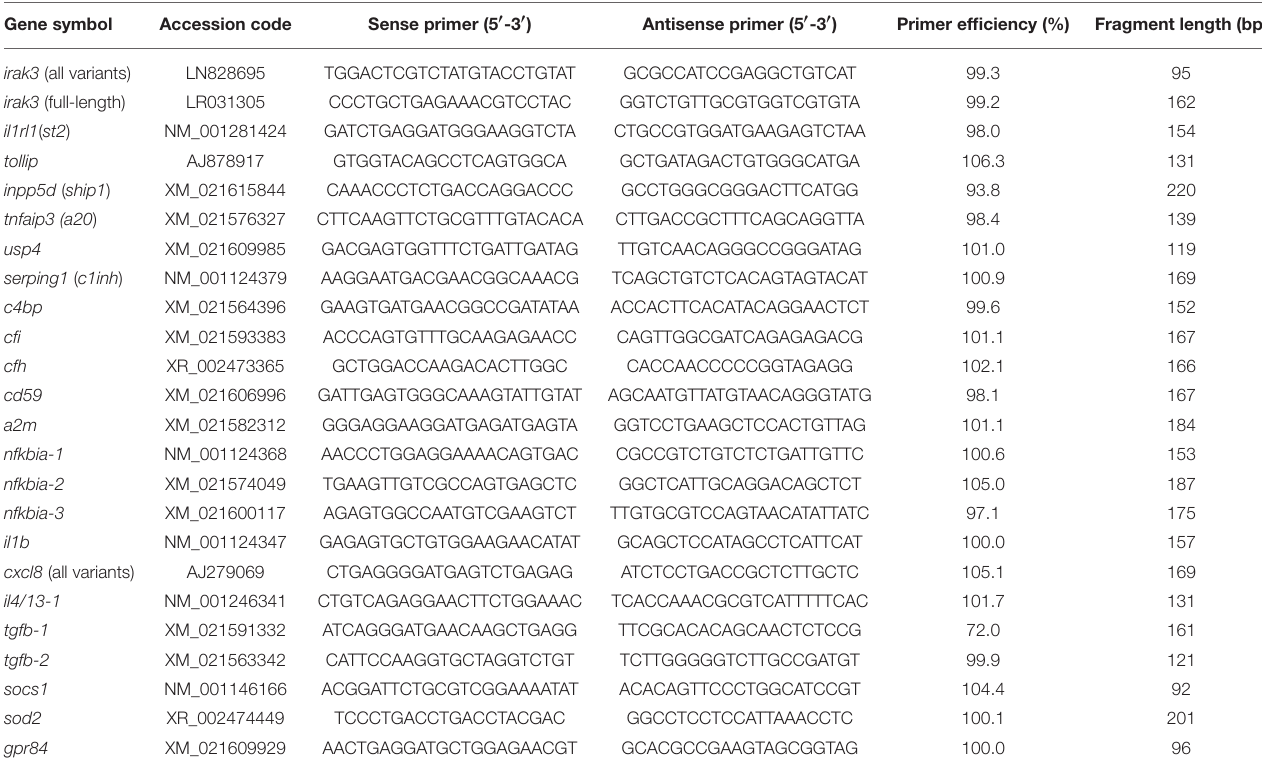
TABLE 1 | Gene-specific primers used for RT-qPCR assays. Gene